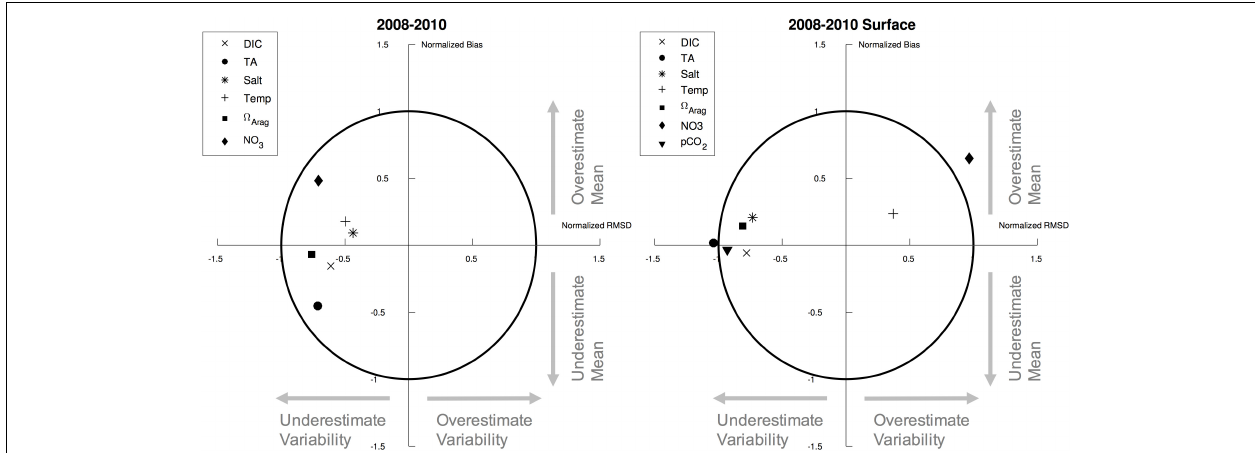
FIGURE 3 | Target diagrams for model variables compared to observed variables from the 2008–2010 BEST-BSIERP cruises for (left) the full water column and (right) surface layer. X -axis is the normalized unbiased RMSD between model and data, multiplied by the sign of the difference between modeled standard deviation and observed standard deviation. Y -axis is the normalized mean bias between model and data. The symbol locations thus illustrate whether the model contains a positive ( Y > 0) or negative ( Y < 0) bias, whether the model standard deviation is larger ( X > 0) or smaller ( X < 0) compared to the observations, and the normalized unbiased RMSD between model and data (absolute value of X